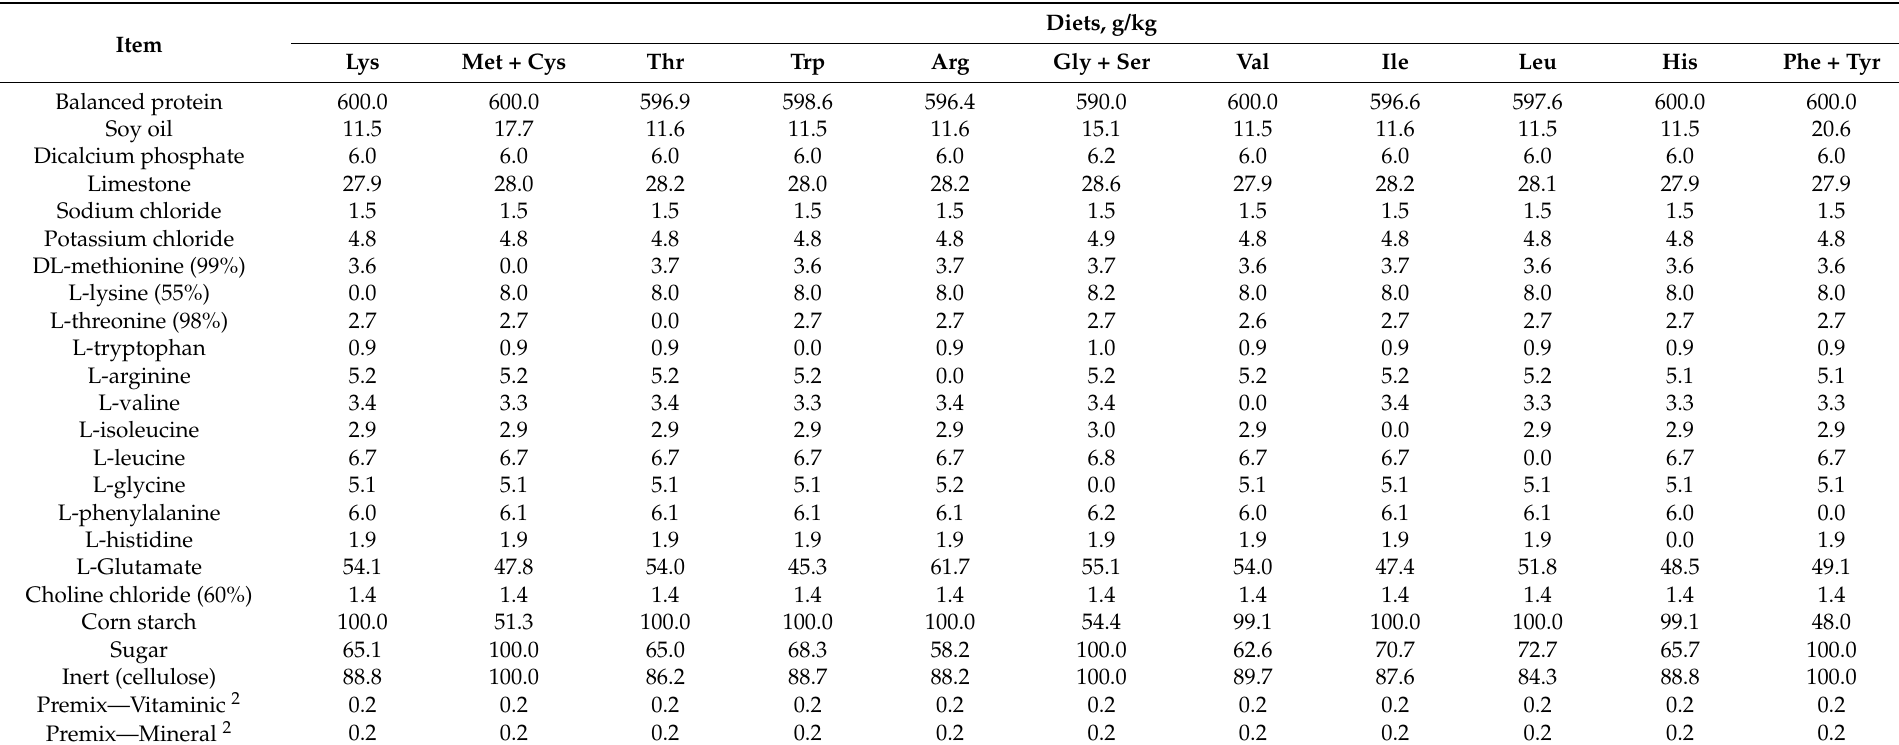
Table 2. Composition of the diet for all tested amino